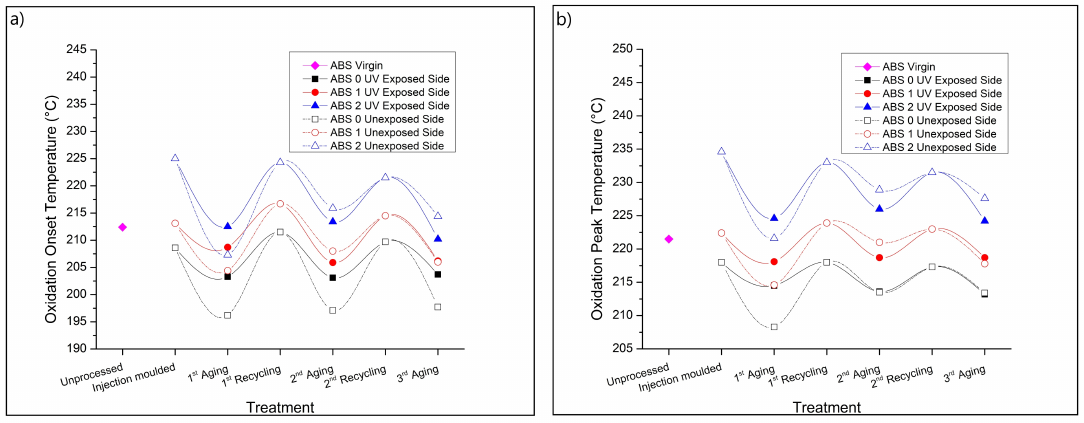
Figure 8. Thermal-oxidative resistance. ( a ) Oxidation onset temperatures and ( b ) oxidation peak temperatures for the samples covered in Table 1, following the procedure in Figure 1. Also added is the virgin ABS data